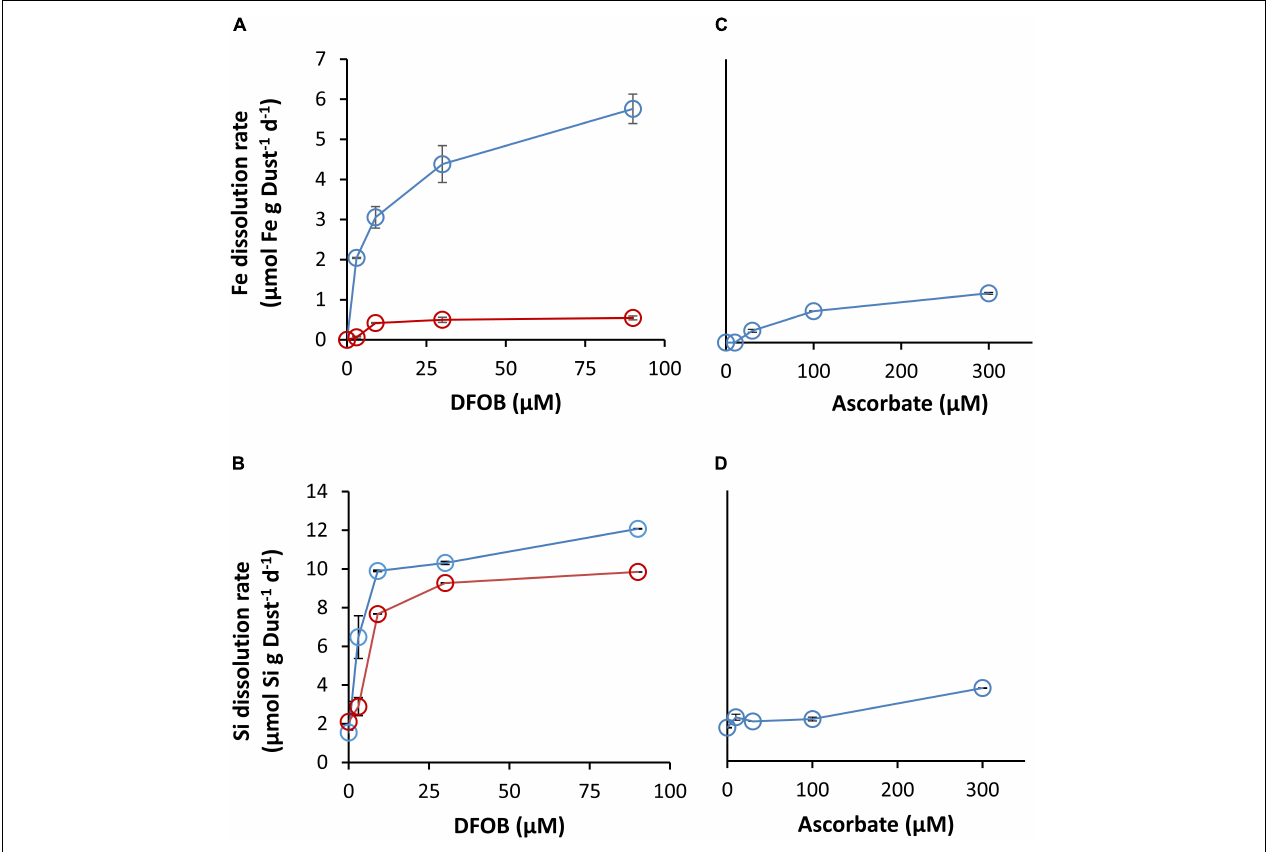
FIGURE 4 | Dissolution rates of Fe and Si from dust, as a function of applied DFOB (A,B) and ascorbate concentrations (C,D) . SD rates were calculated separately for 0–8 h (blue) and 24–192 h (red). RD rates were calculated for the first 24